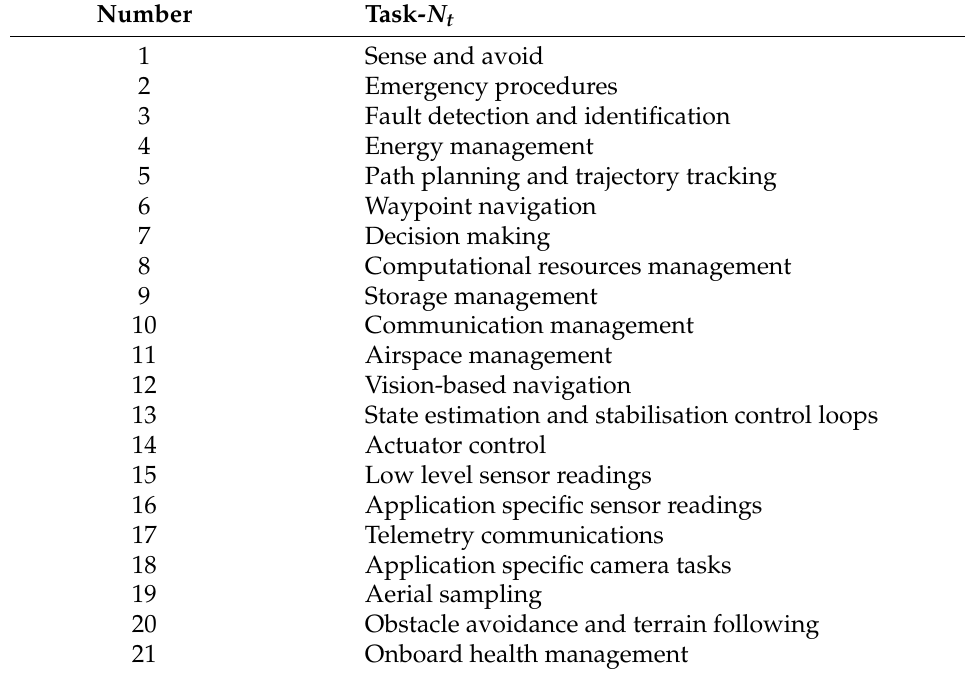
Table 1. Most common tasks executed in